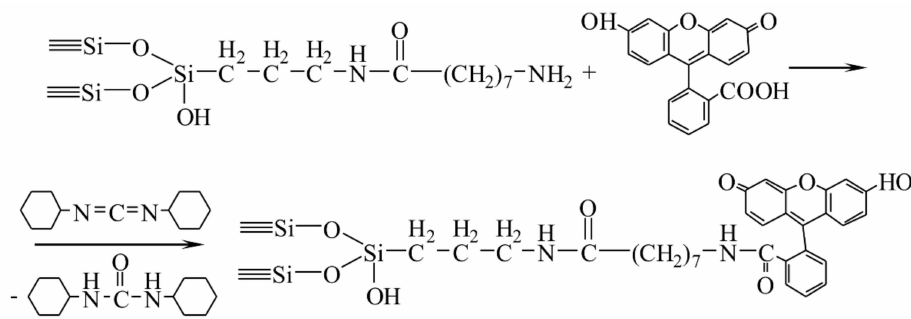
Figure 8. Immobilization of fluorescein. The drug release kinetics (Figure 9) was studied by desorption of immobilized adeno- sine in Krebs–Henseleit buffer, with salt content close to that of the blood composition [59]. The most rapid release of the drug has been observed under adsorption immobilization, while the slowest was observed under ion binding. This fact can be explained by the instability of azomethine groups formed under adenosine binding by glutaraldehyde. The immobilization of bradykinin as a cardioprotector (a peptide hormone) on ami- nated aerosil has been carried out by the glutaraldehyde